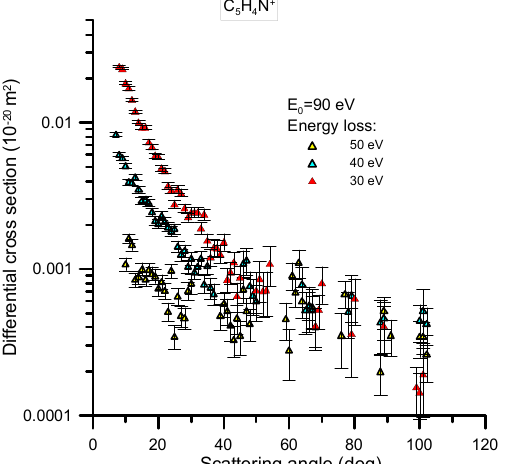
Figure 3. Double differential cross section for the production of the pyridine H-loss ion (C 5 H 4 N + ), under 90 eV electron impact ionization where the scattered electron has different energy loss values (30, 40 and 50 eV). See also the legend in the figure.